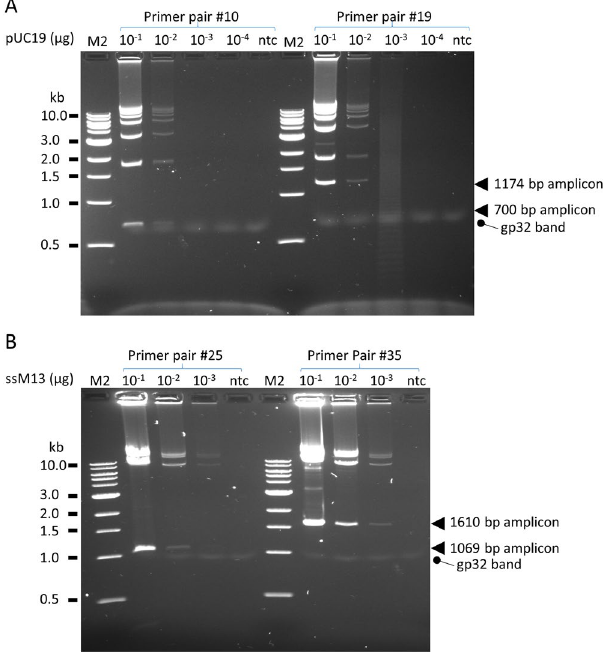
Figure 4. Sensitivity of gp32-assisted isothermal amplification. A. pUC19 dsDNA template with primer pair #10 or #19 which specify, respectively, single amplicons of 700 bp and 1174 bp in size. The amplification reaction contained 456 ng/ μ l of gp32. B. ssM13 template with primer pair #25 or #35 which specify, respectively, single amplicons of 1069 bp and 1610 bp in size. The amplification reaction contained 302 ng/ μ l of gp32. Arrows indicate the locations of single amplicons. Incubation time for both template was 1 hour. M2, 1 kb